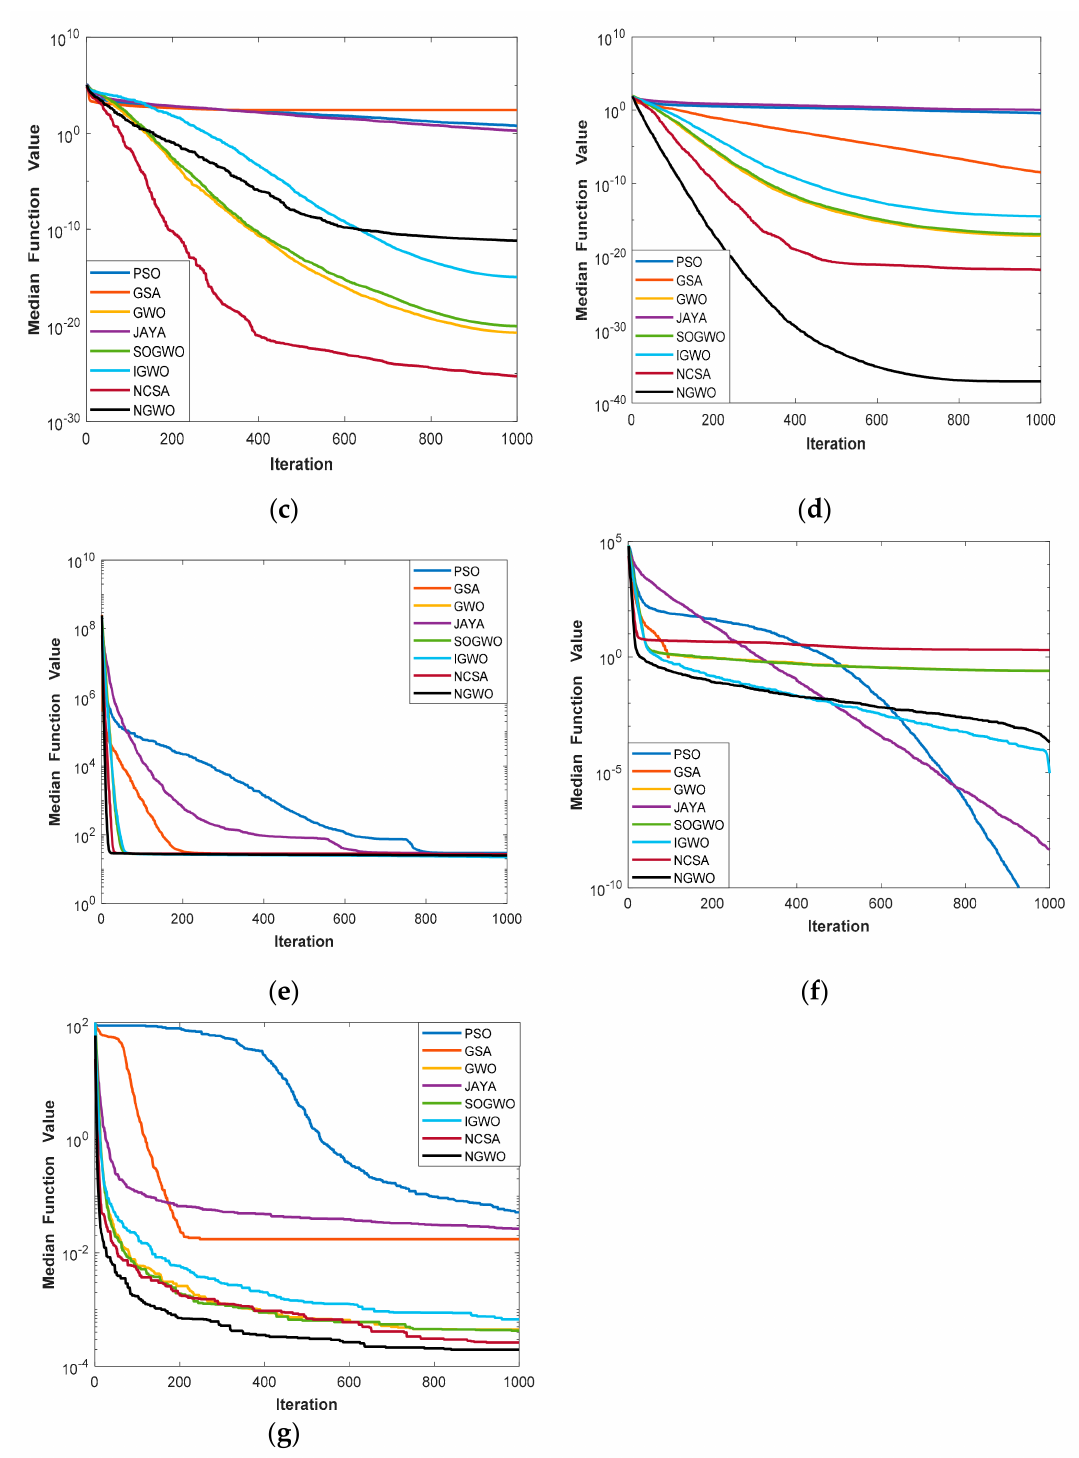
Figure 2. Convergence characteristics of the algorithms for unimodal benchmark functions (F 1 –F 7 ). Here, ( a ) represents benchmark function F 1 , ( b ) represents benchmark function F 2 , ( c ) represents benchmark function F 3 , ( d ) represents bench- mark function F 4 , ( e ) represents benchmark function F 5 , ( f ) represents benchmark function F 6 , ( g ) represents benchmark function F 7